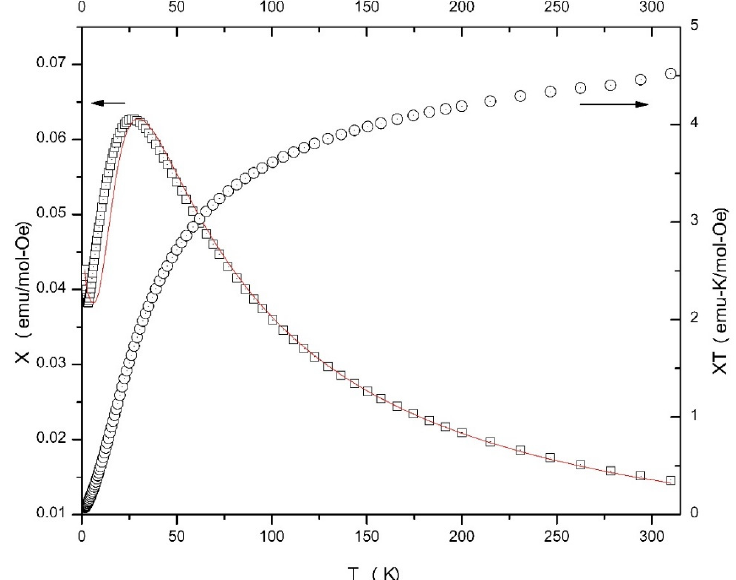
Figure 10. χ vs. T and χΤ vs. T plots for compound 2 . Arrows on the plots indicate which y -axis applies to. Which data. The solid line is the best fit of the χ vs. T data to the cyclic S = 1 tetramer model; see the text for details.